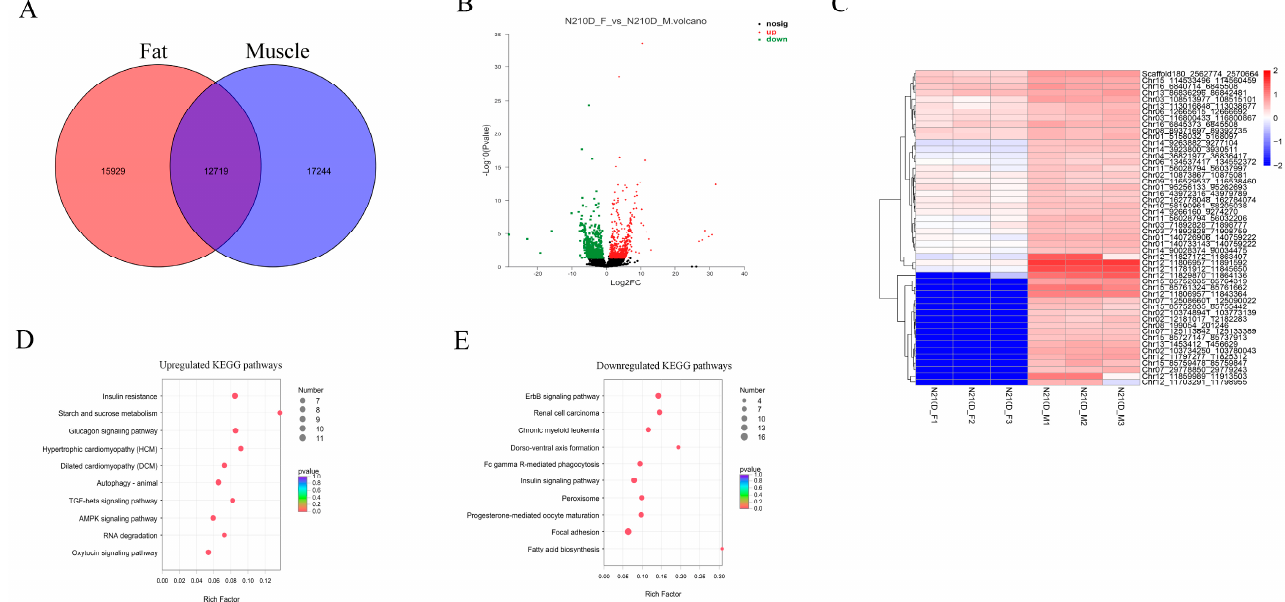
Figure 4. Expression analysis of circRNAs between skeletal muscle and subcutaneous fat of Ningxiang pig. ( A ) Venn chart of circRNAs detected in skeletal muscle and subcutaneous fat of Ningxiang pig. ( B ) Volcano plot of all DE circRNAs between skeletal muscle and subcutaneous fat. The x-axis represents the value of log2 (muscle/fat) and the y-axis represents the value of -log10 ( p -value). Green, black, and red dots represent downregulated, unchanged, and upregulated DEcircRNAs, respectively, between the skeletal muscle and subcutaneous fat groups. ( C ) Heatmap illustrating the relative expression of top 50 DE circRNAs from three 210 d skeletal muscle and three 210 d subcutaneous fat tissues, with rows showing circRNAs and columns showing tissues. ( D , E ) KEGG pathway analysis of DE circRNAs in the skeletal muscle vs. subcutaneous fat tissues. The top 10 enriched KEGG pathways ranked by p -values are shown.